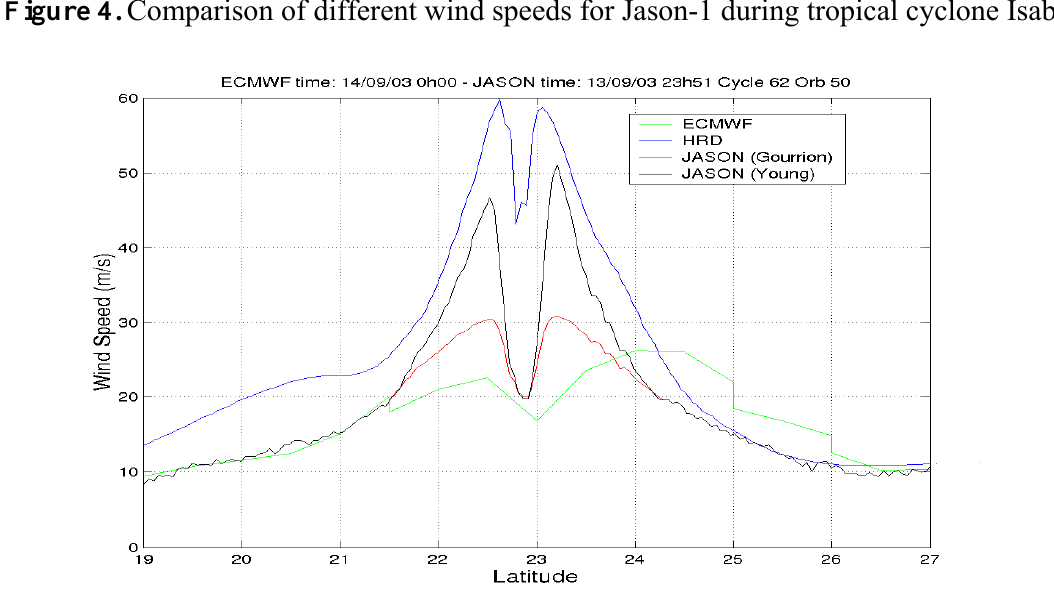
Figure 4. Comparison of different wind speeds for Jason-1 during tropical cyclone